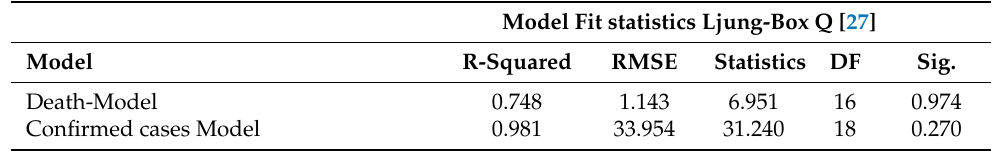
Table 2. Results: model fit statistics and Ljung-Box Q [27].